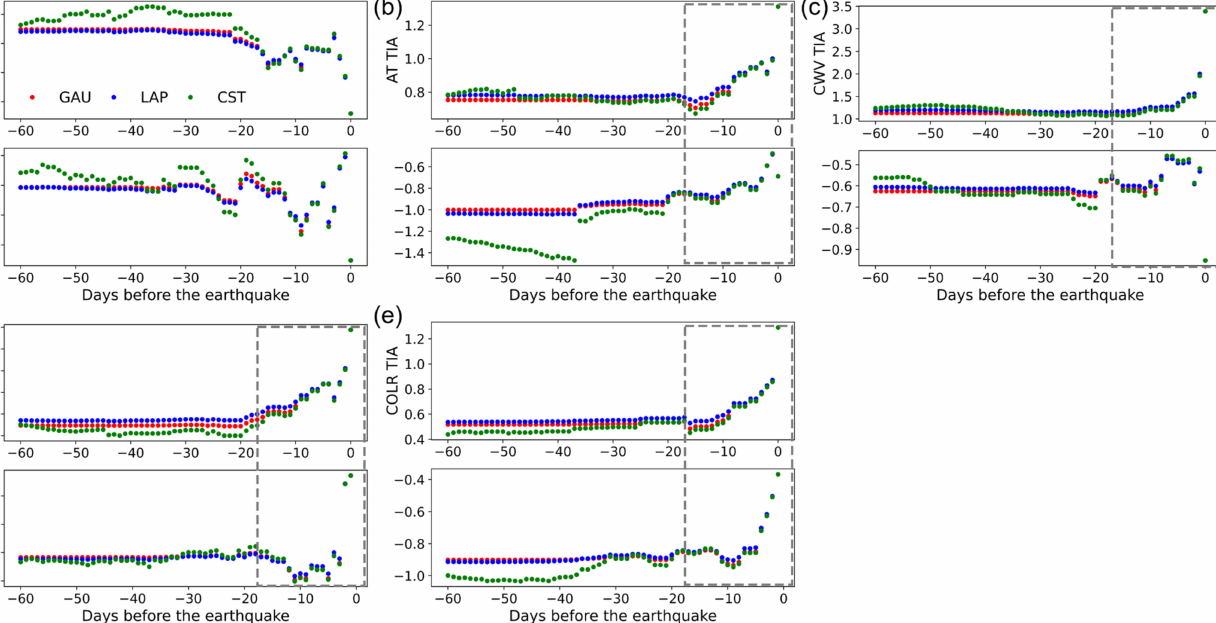
Figure 4. Trend characteristics for multiparametric temporal integrated anomalies (TIAs) before the 2009 M7.7 Papua earthquake, Indonesia, demonstrating enhanced positive TIAs close to earthquake occurrence. ( a ) Skin temperature (ST) TIA; ( b ) air temperature (AT) TIA; ( c ) total integrated column water vapor burden (CWV) TIA; ( d ) outgoing longwave radiation (OLR) TIA; ( e ) clear-sky OLR (COLR) TIA. The two subfigures for each anomaly show the positive and negative TIAs, respectively. Negative days at the abscissa denote the days before the earthquake. The gray dashed frame indicates the TIA trend characteristics. The red, blue, and green dots denote Gaussian (GAU), Laplace (LAP), and Constant (CST) weight integration functions,